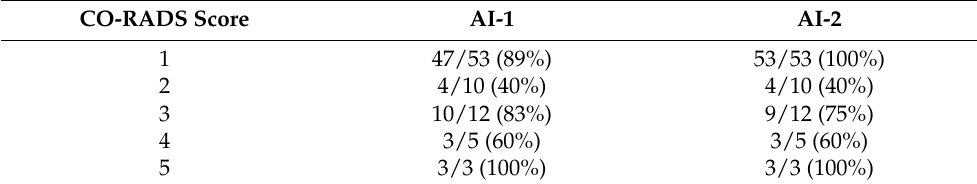
Table 4. Number of correct matches for each CO-RADS